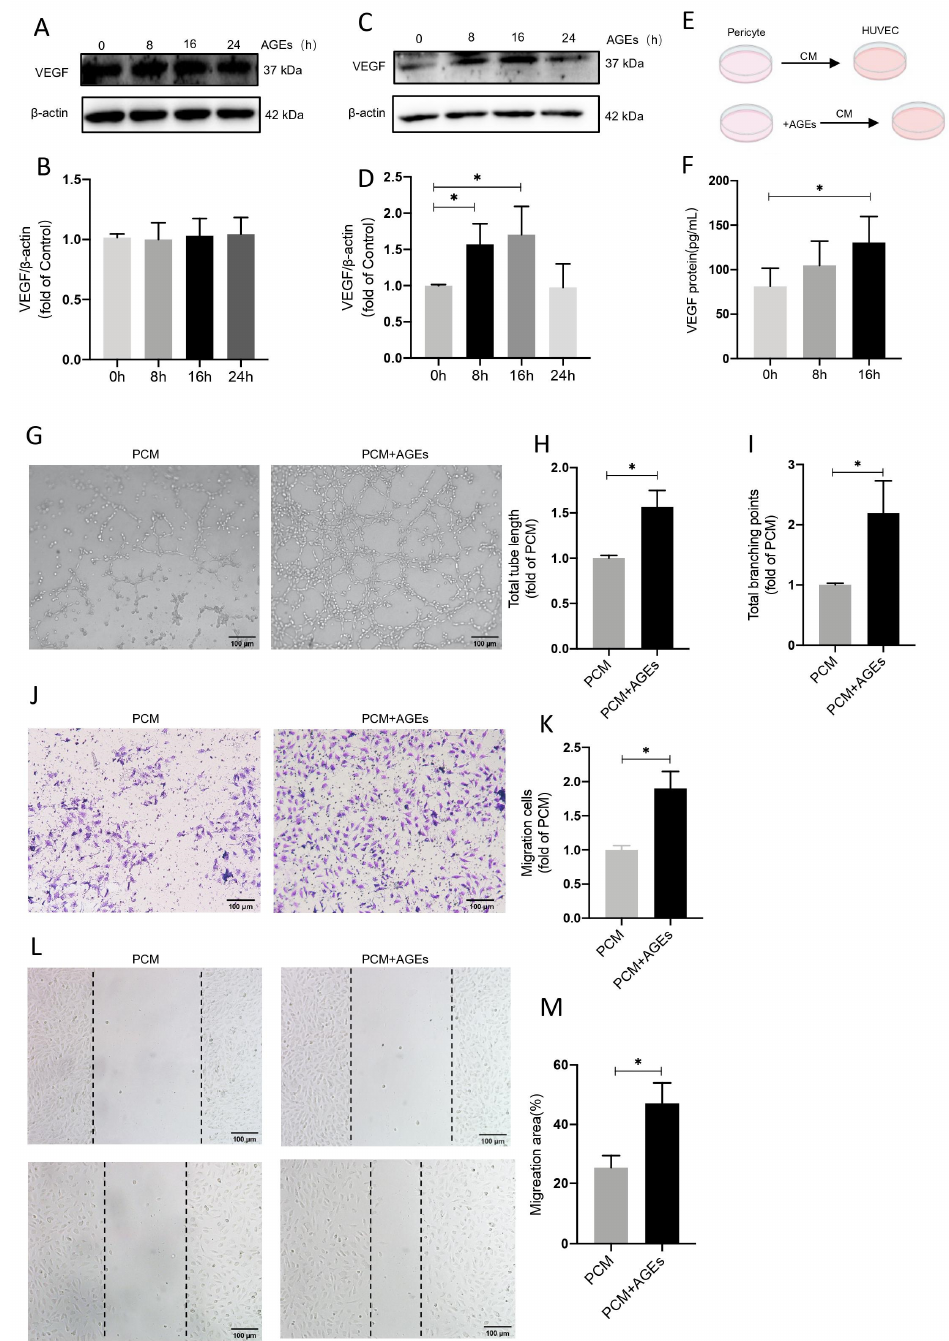
Figure 6. AGEs stimulate increased secretion of VEGF by pericytes and promote endothelial cell angiogenesis. ( A , B ) The temporal effect of AGEs stimulation on HUVECs was studied by Western blot, showing VEGF protein expression at 0, 8, 16, and 24 h, n = 6. ( C , D ) Temporal effect of AGEs stimulation on pericytes studied by Western blot, showing VEGF protein expression at 0, 8, 16, and 24 h of expression, n = 6, * p < 0.05 vs. 0 h. ( E ) Supernatant from pericytes was collected as a conditioned medium (CM) for endothelial cell culture. ( F ) Elisa assay for VEGF expression in the supernatant of pericyte medium. ( G – I ) Formation of HUVECs tubes in Matrigel assay after stimulation of endothelial cells with CM with or without AGEs, respectively, n = 4, * p < 0.05 vs. PCM, Scale bar: 100 µ m. ( J , K ) Migration capacity in transwell migration assay, n = 4, * p < 0.05 vs. PCM, Scale bar: 100 µ m. ( L , M ) Migration of HUVECs at specified times as determined by scratch tests. n = 4, * p < 0.05 vs. PCM, Scale bar: 100 µ m. * indicates significance between the indicated